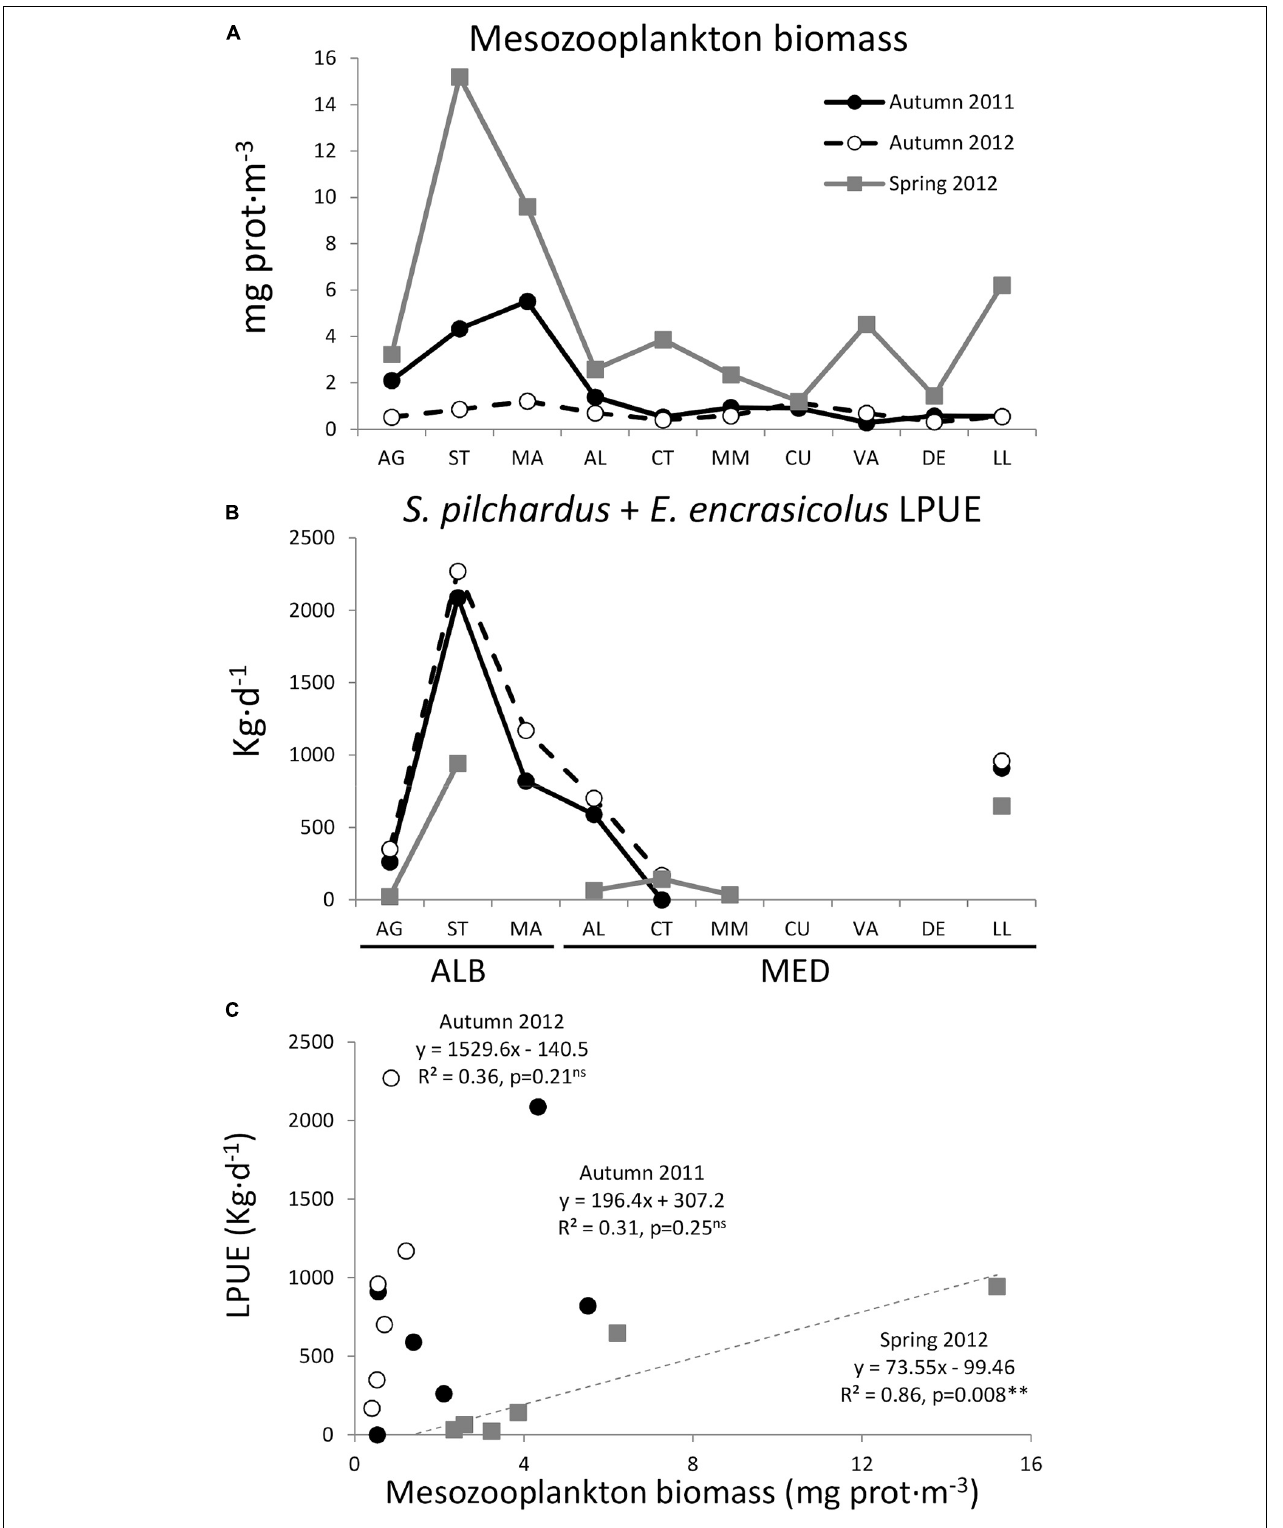
FIGURE 8 | Distribution from AG to LL of (A) mean mesozooplankton biomass ( > 200 µ m, mg prot · m − 3 ), (B) combined European sardine ( Sardina pilchardus ) and European anchovy ( Engraulis encrasicolus ) LPUE (kg · d − 1 ), and (C) Pearson correlations between zooplankton biomass and SPF LPUE in autumn 2011, spring 2012, and autumn 2012. ns: p > 0.05, ∗∗ p ≤ 0.01.